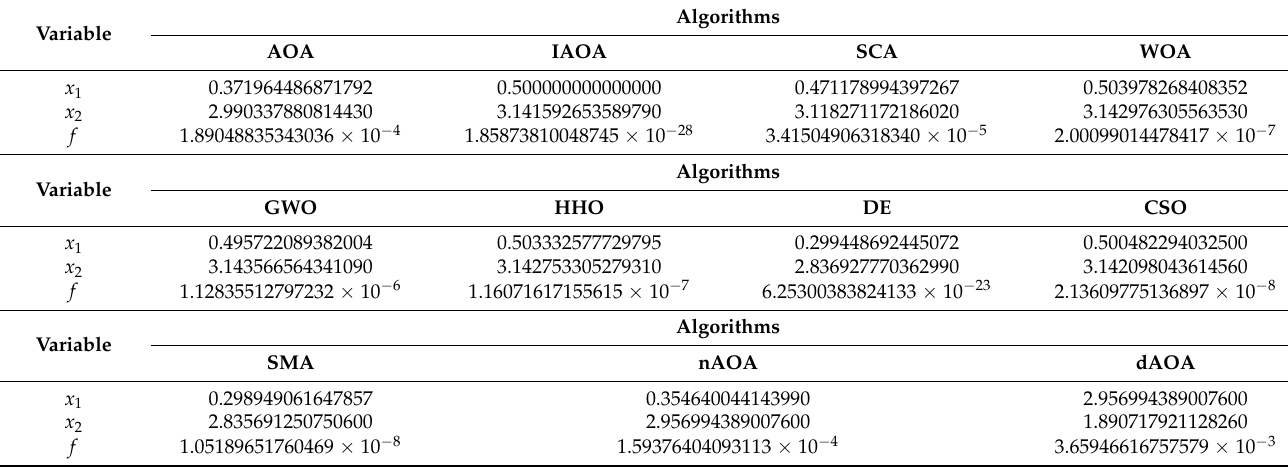
Table 5. Comparison of the experimental results for problem05.